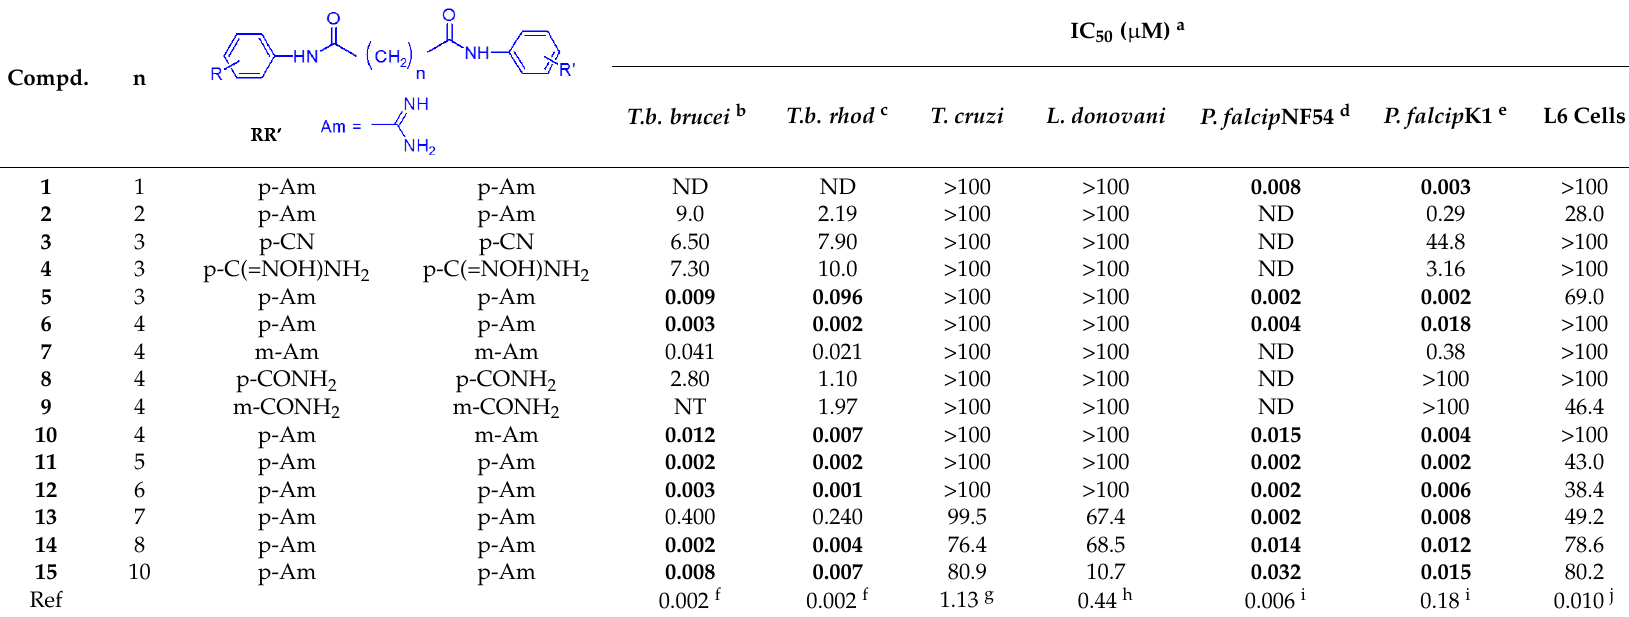
Table 1. In vitro antiparasitic and cytotoxic properties of alkanediamide-linked bisbenzamidines and analogs. Compd.